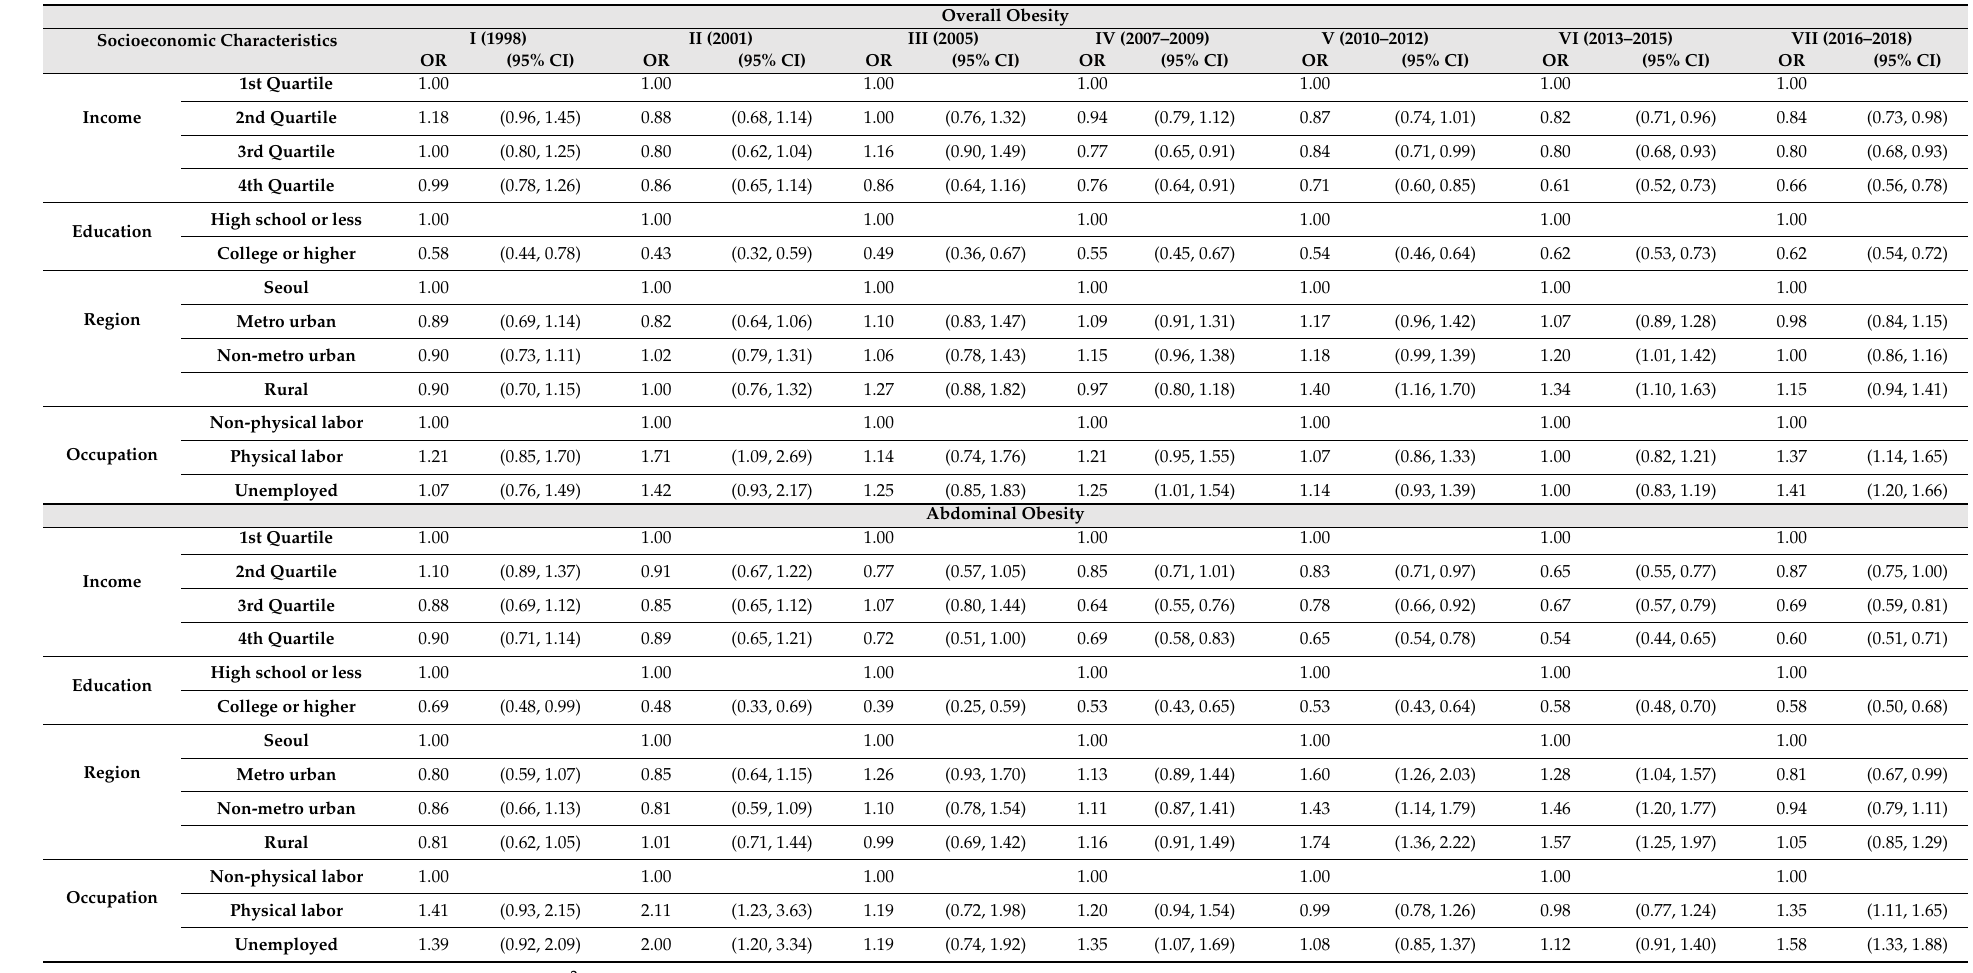
Table 3. Odds ratios (OR) and 95% confidence intervals (CI) for the associations of socioeconomic factors (income, education, region, occupation) with overall and abdominal obesity prevalence in women: the KNHANES